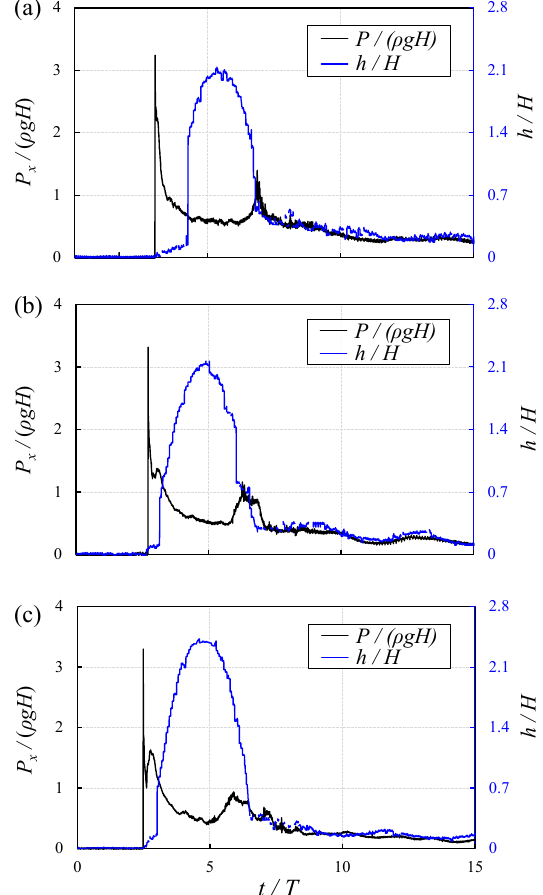
Figure 9. Non − dimensional time − history of the horizontal dynamic pressure and surge height for Figure 9. Non-dimensional time-history of the horizontal dynamic pressure and surge height for different impoundment depths: ( a ) H = 200 m; ( b ) H = 250 mm; ( c ) H = 300mm. different impoundment depths: ( a ) H = 200 m; ( b ) H = 250 mm; ( c ) H = 300 mm.